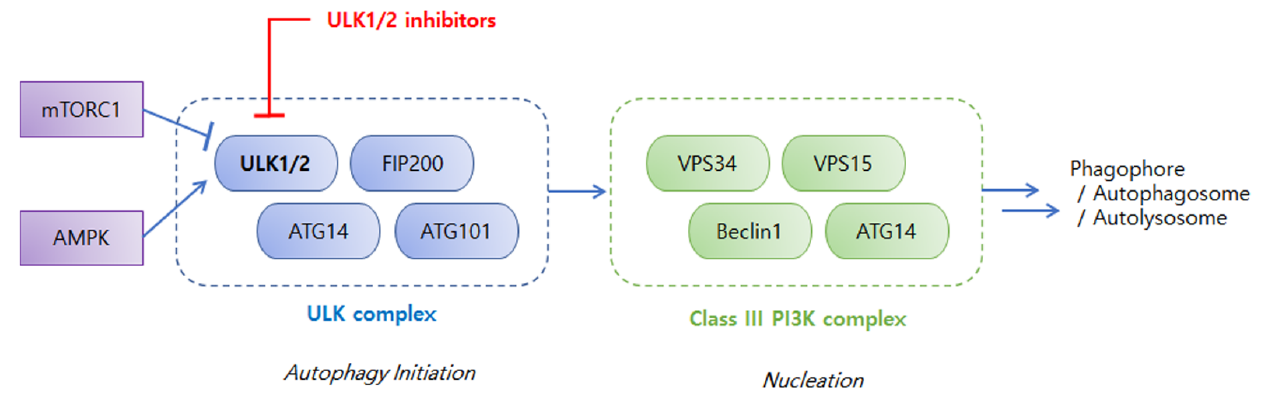
Figure 1. Early-stage regulations of the autophagy process. mTORC1 = mammalian or mechanistic target of rapamycin complex 1; AMPK = AMP-activated protein kinase; ULK1/2 = Unc-51-like au- tophagy activating kinase 1 or 2; FIP200 = focal adhesion kinase family-interacting protein of 200 kDa; ATG14 = autophagy-related protein 14; ATG101 = autophagy-related protein 101; VPS34 = vacuolar protein sorting 34; VPS15 = vacuolar protein sorting 15; PI3K = phosphoinositide-3-kinase.